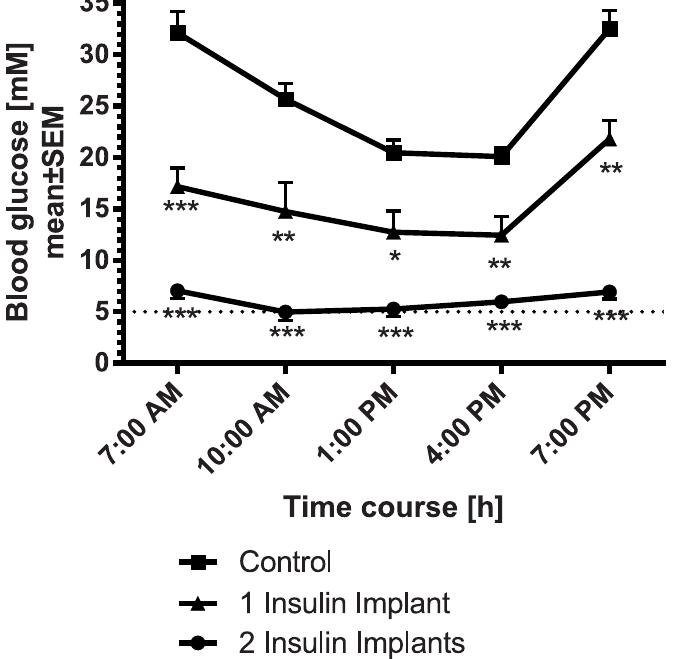
Fig 5. Blood glucose profile in STZ-diabetic rats 26 days after implantation of insulin implants (1 or 2 implants/animal; n = 7 per group); normoglycemia is indicated by the dotted line. * p < 0.05, ** p < 0.01, *** p < 0.001 vs.